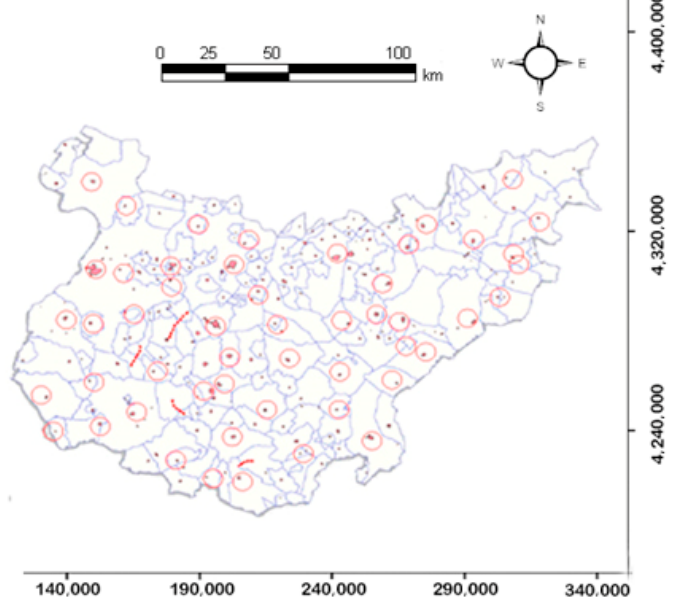
Figure 2. Map of the spatial distribution of the meteorological stations. “Coordinate system is ETRS89/UTM zone 30” N.